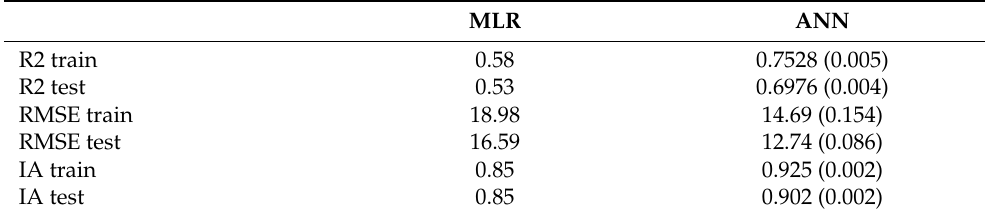
Table 2. The mean performance statistics of the selected model with standard deviation compared to multiple linear